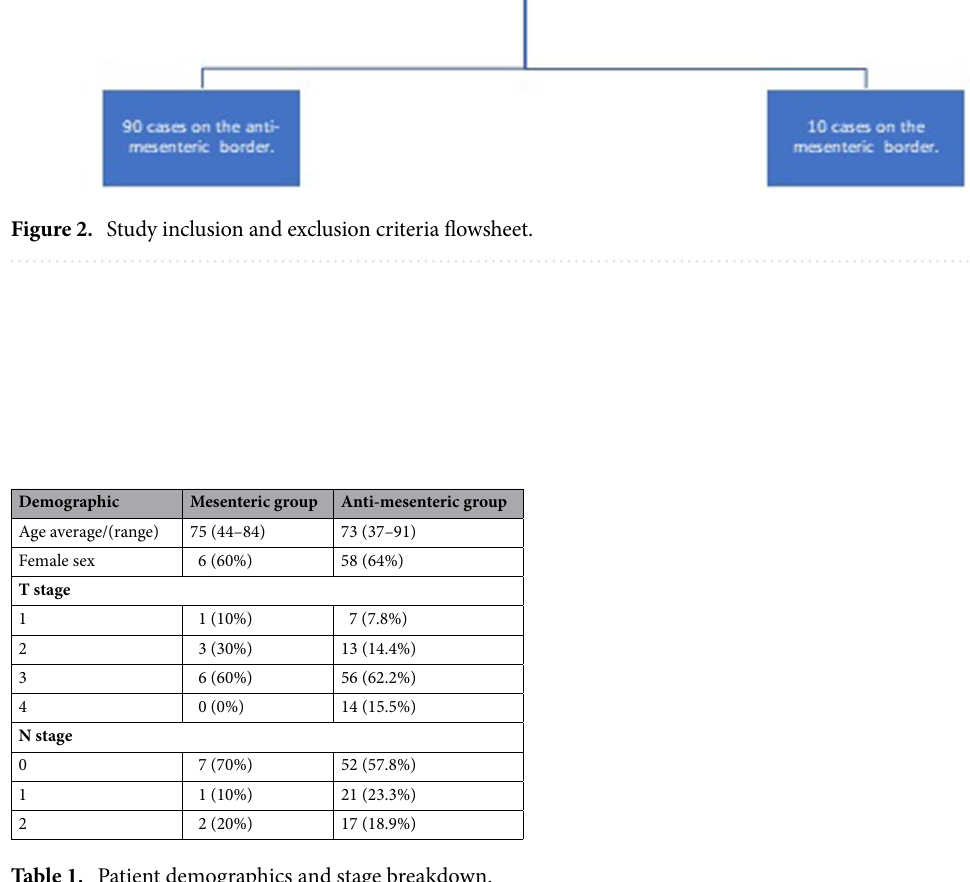
Table 1. Patient demographics and stage